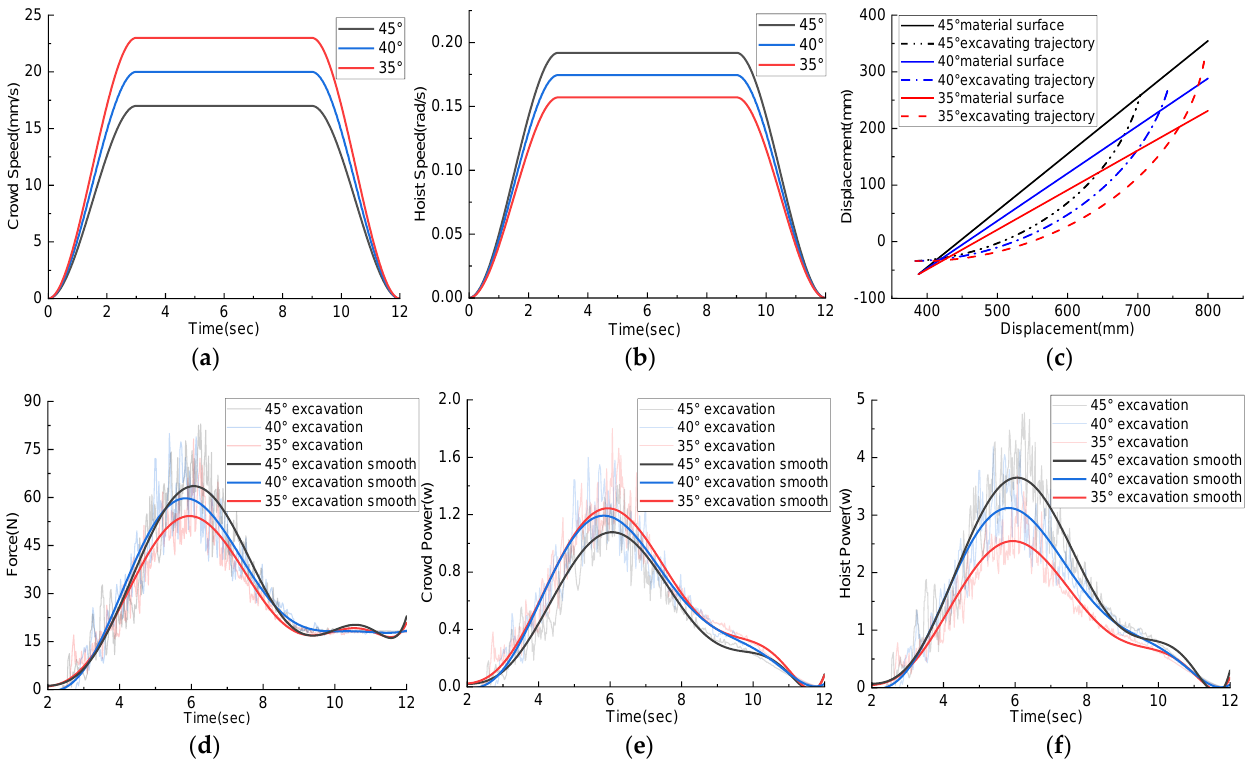
Figure 12. Comparison of simulation results under different stacking angles: ( a ) Crowd speed; ( b ) Hoist speed; ( c ) Excavating trajectory; ( d ) Excavating resistance; ( e ) Crowd power; ( f ) Hoist power.